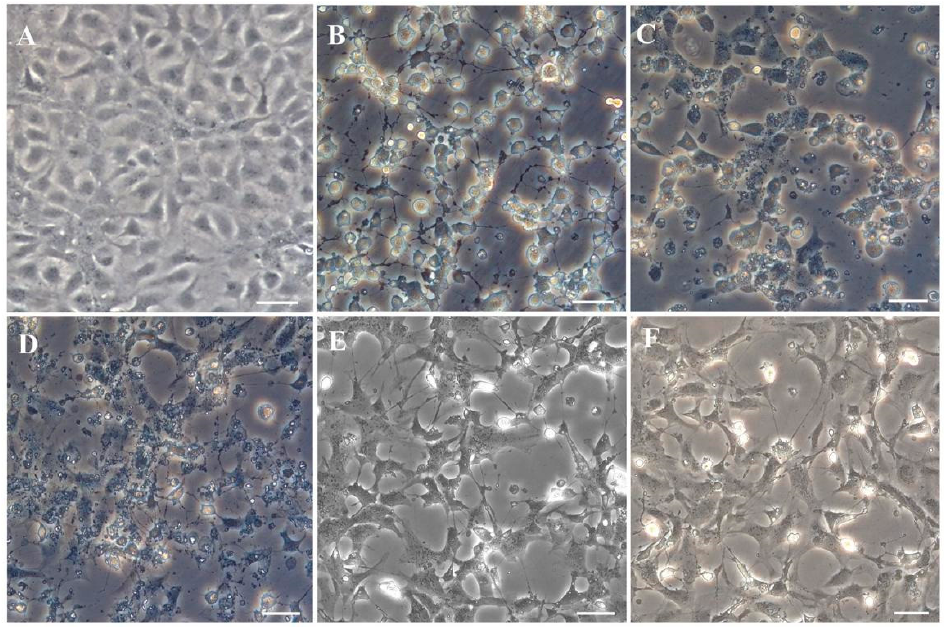
Figure 6. Observed CPE of JFSP cells infected by BIV, VHSV, HIRRV, IHNV, or LCDV through an inverted microscope. ( A ) Control group. CPE of JFSP cells infected with ( B ) BIV, ( C ) VHSV, and ( D ) HIRRV at 36 h p.i. ( E ) CPE of IHNV-infected JFSP cells at 48 h p.i. ( F ) CPE of LCDV-infected JFSP cells at 3 d p.i. Scale bar = 50 μ m.